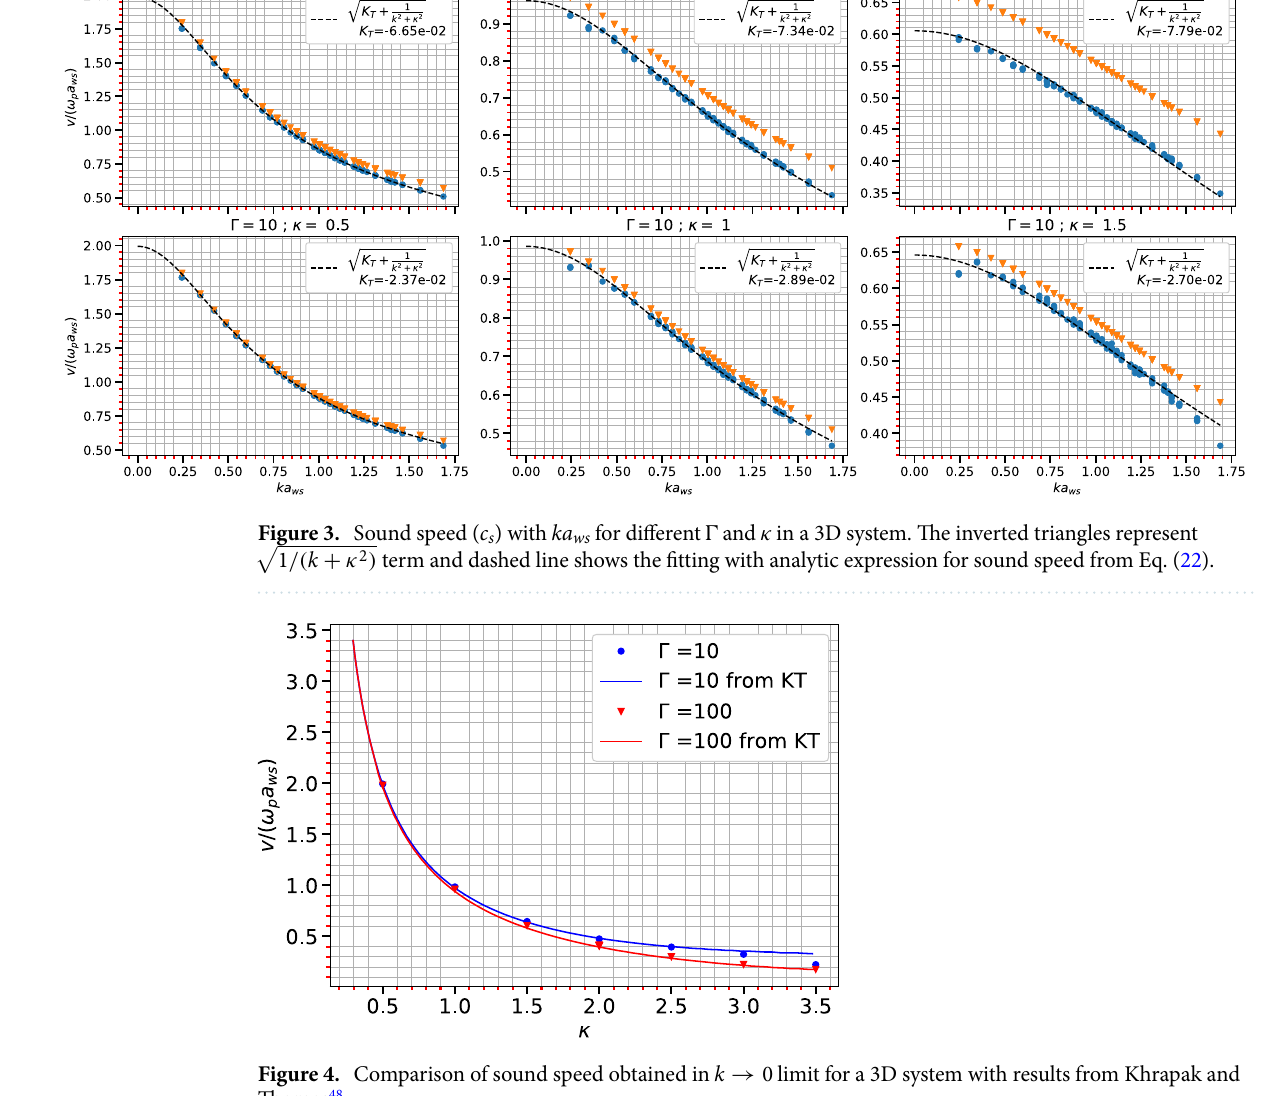
Figure 4. Comparison of sound speed obtained in k Thomas 48 .